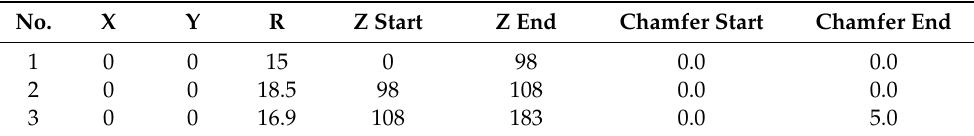
Table 2. Pseudocode of geometry import algorithm to SOLIDWORKS software.